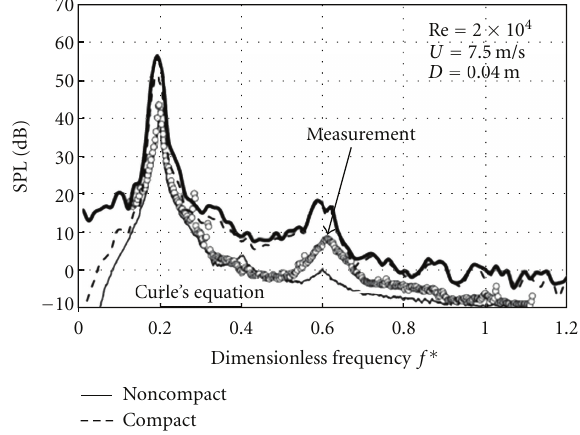
Figure 4: SPL spectrum of computational end experimental results.